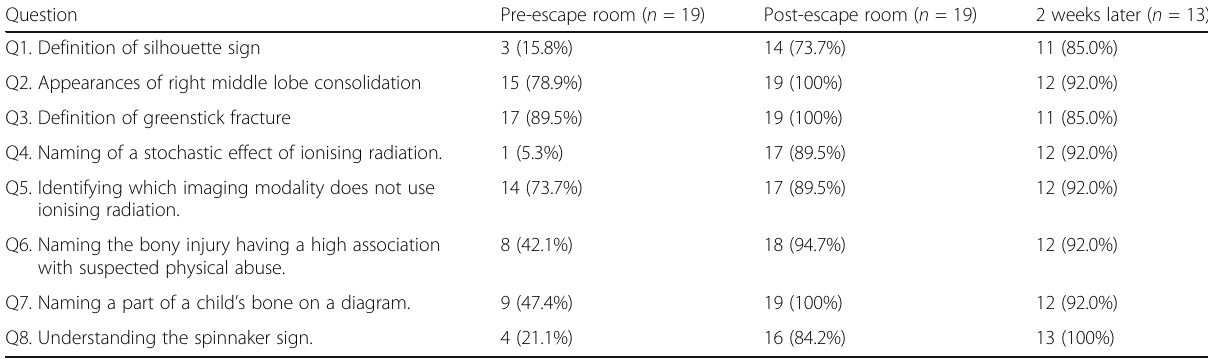
Table 3 Number and proportion of each question in the single best answer (SBA) test which were answered correctly at each time interval Question